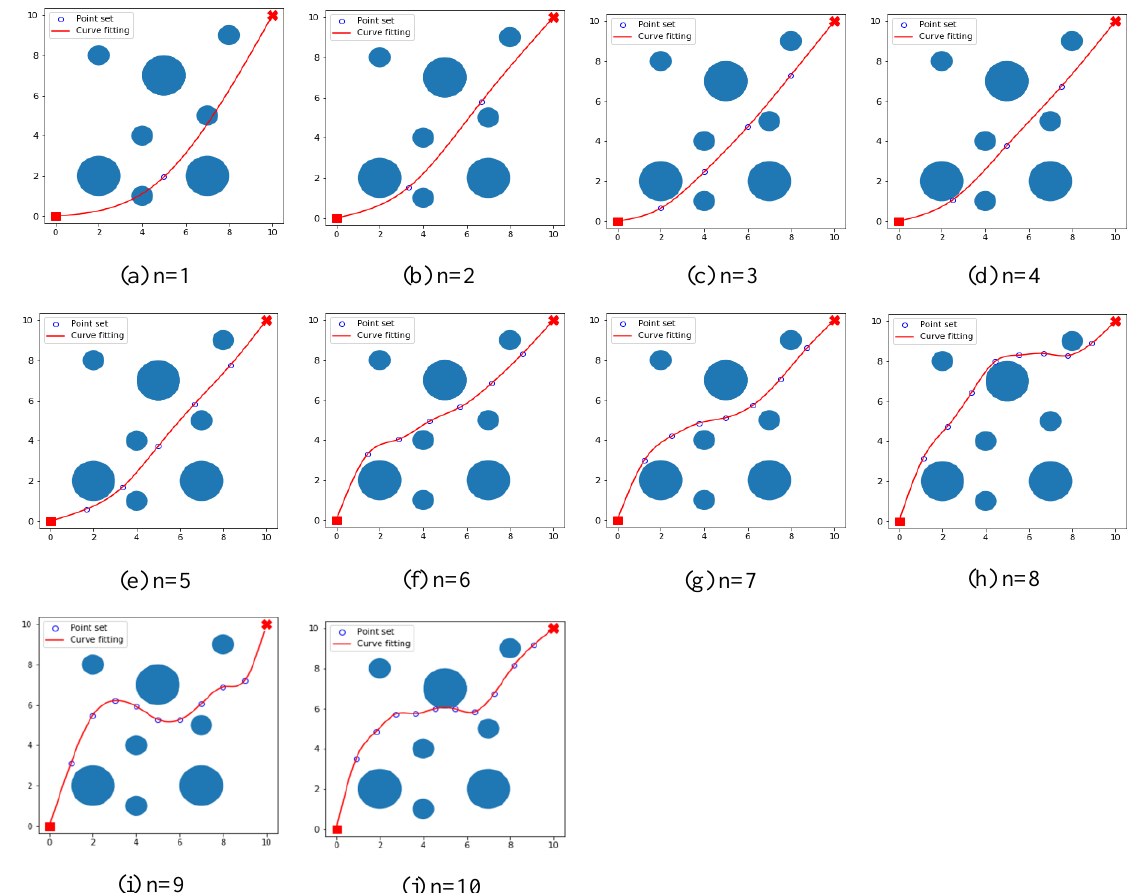
Figure 7. Flowchart of robot path planning based on the proposed algorithm.